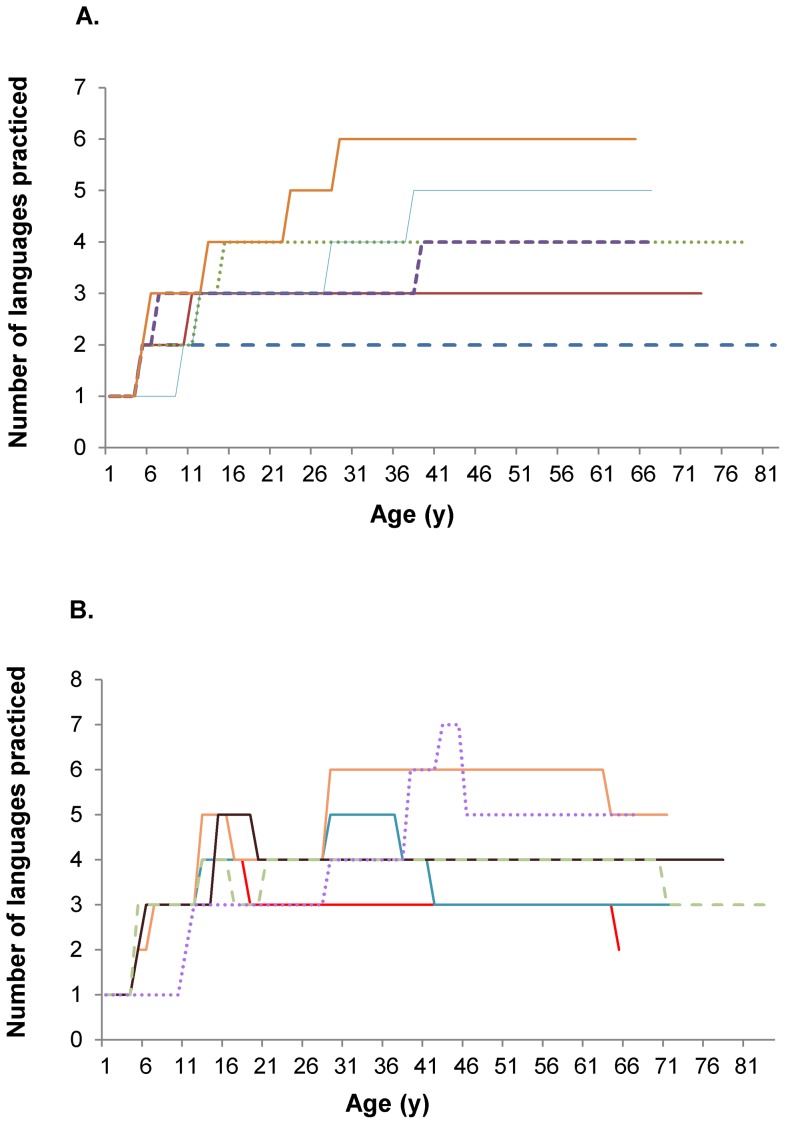
Acquisition of multilingualism in the studied population.
Part A. Typical progression: sequential and increasing process of learning and practicing multilingualism. (For each stage of multilingualism, either individuals stayed at a specified level, or they progressed to the next step i.e. they learned an additional language.) Description of the 6 models of progression found among the 168 individuals for which the learning process represents the acquisition of one language after another (keeping the practice of all of them). Part B. Atypical and unordered progression of learning and practicing multilingualism. Illustration of the 6 models of atypical progression exhibited by the 64 subjects learning 2 or 3 languages in the same period of time and/or losing the practice of one or 2 languages at some point in their lives.